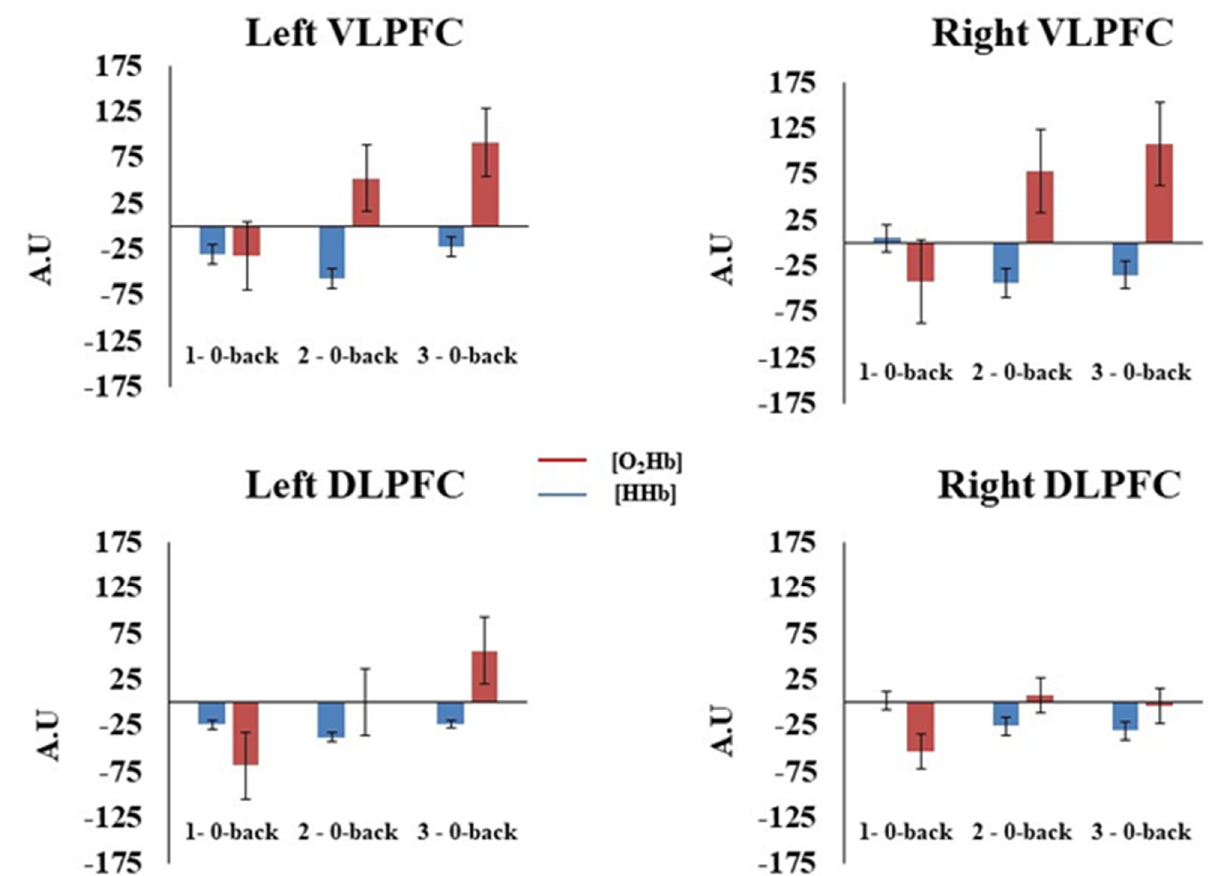
Figure 4. Hemodynamic concentration changes in the prefrontal cortex as a function of cognitive load, hemisphere, and channel during n-back. Bars represent standard error. 1–0-back = Activation 1; 2–0-back = Activation 2; 1–0-back = Activation 3. VLPFC = ventrolateral prefrontal cortex; DLPFC = dorsolateral prefrontal cortex.